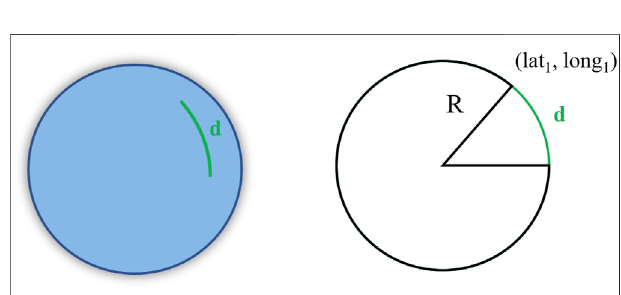
FIGURE 4 | Graphical explanation of the haversine